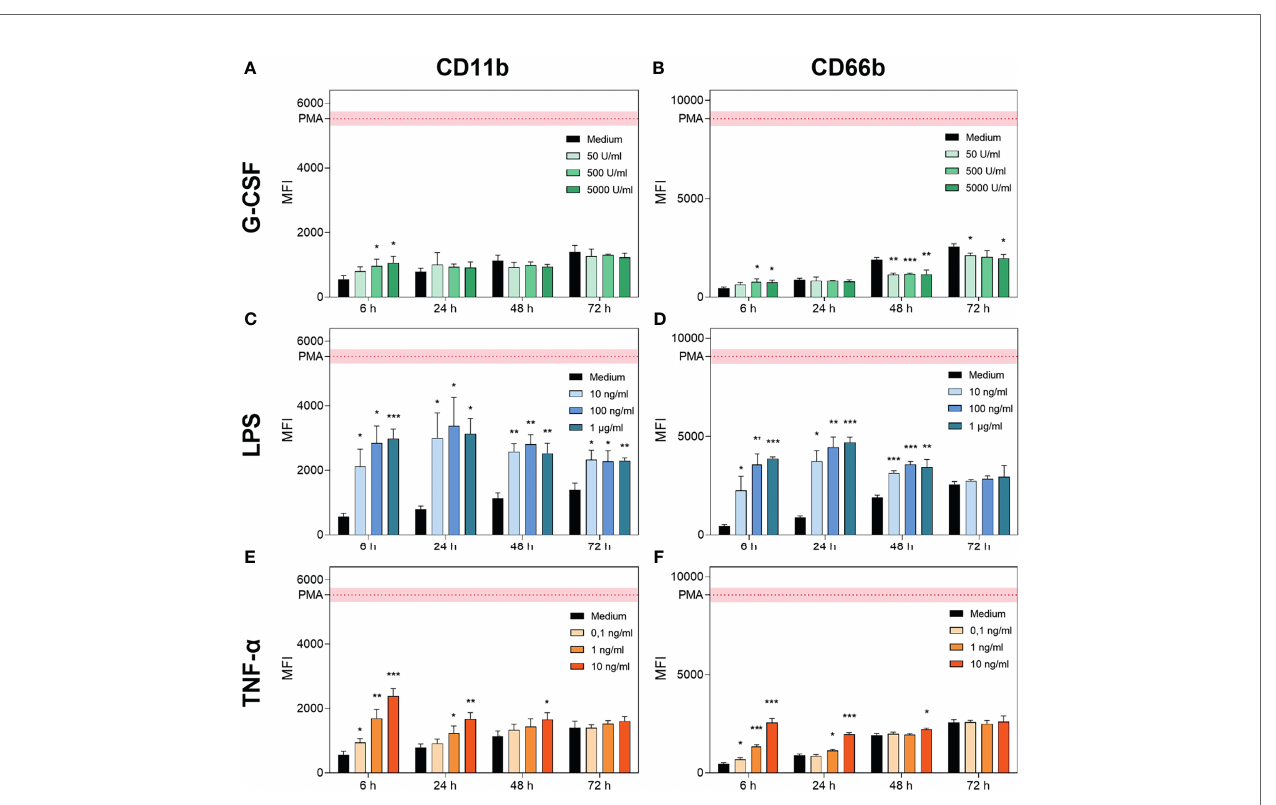
FIGURE 2 | G-CSF, LPS and TNF- a regulate CD11b and CD66b expression in neutrophils. CD11b and CD66b expression levels were analysed by FACS after incubation of neutrophil granulocytes with G-CSF (A, B) , LPS (C, D) , TNF- a (E, F) or with only the medium for 6 h, 24 h, 48 h and 72 h. Activation by a positive control (PMA) was included for reference. Values are represented as means ± SD of, n = 3 of the mean fl uorescence intensity (MFI). Differences between the untreated control group and one treated group each were calculated individually by student ’ s t-test. Levels of signi fi cance were set at < 0.05 (*), < 0.01 (**), < 0.001